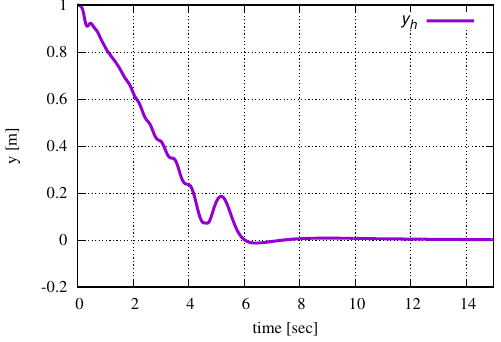
Figure 18. Case 2: Time variation of the y coordinate of the head position.